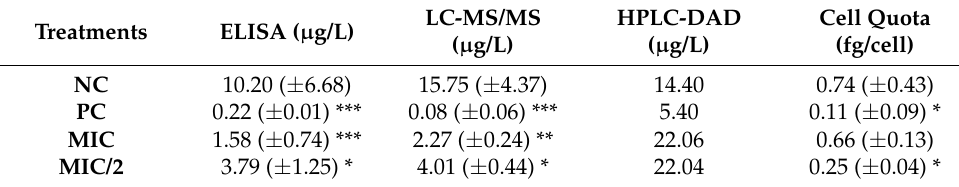
Table 1. Effect of R. aquatilis aqueous extracts on intracellular and cell quota MCs at T final. Treatments ELISA ( µ g/L)